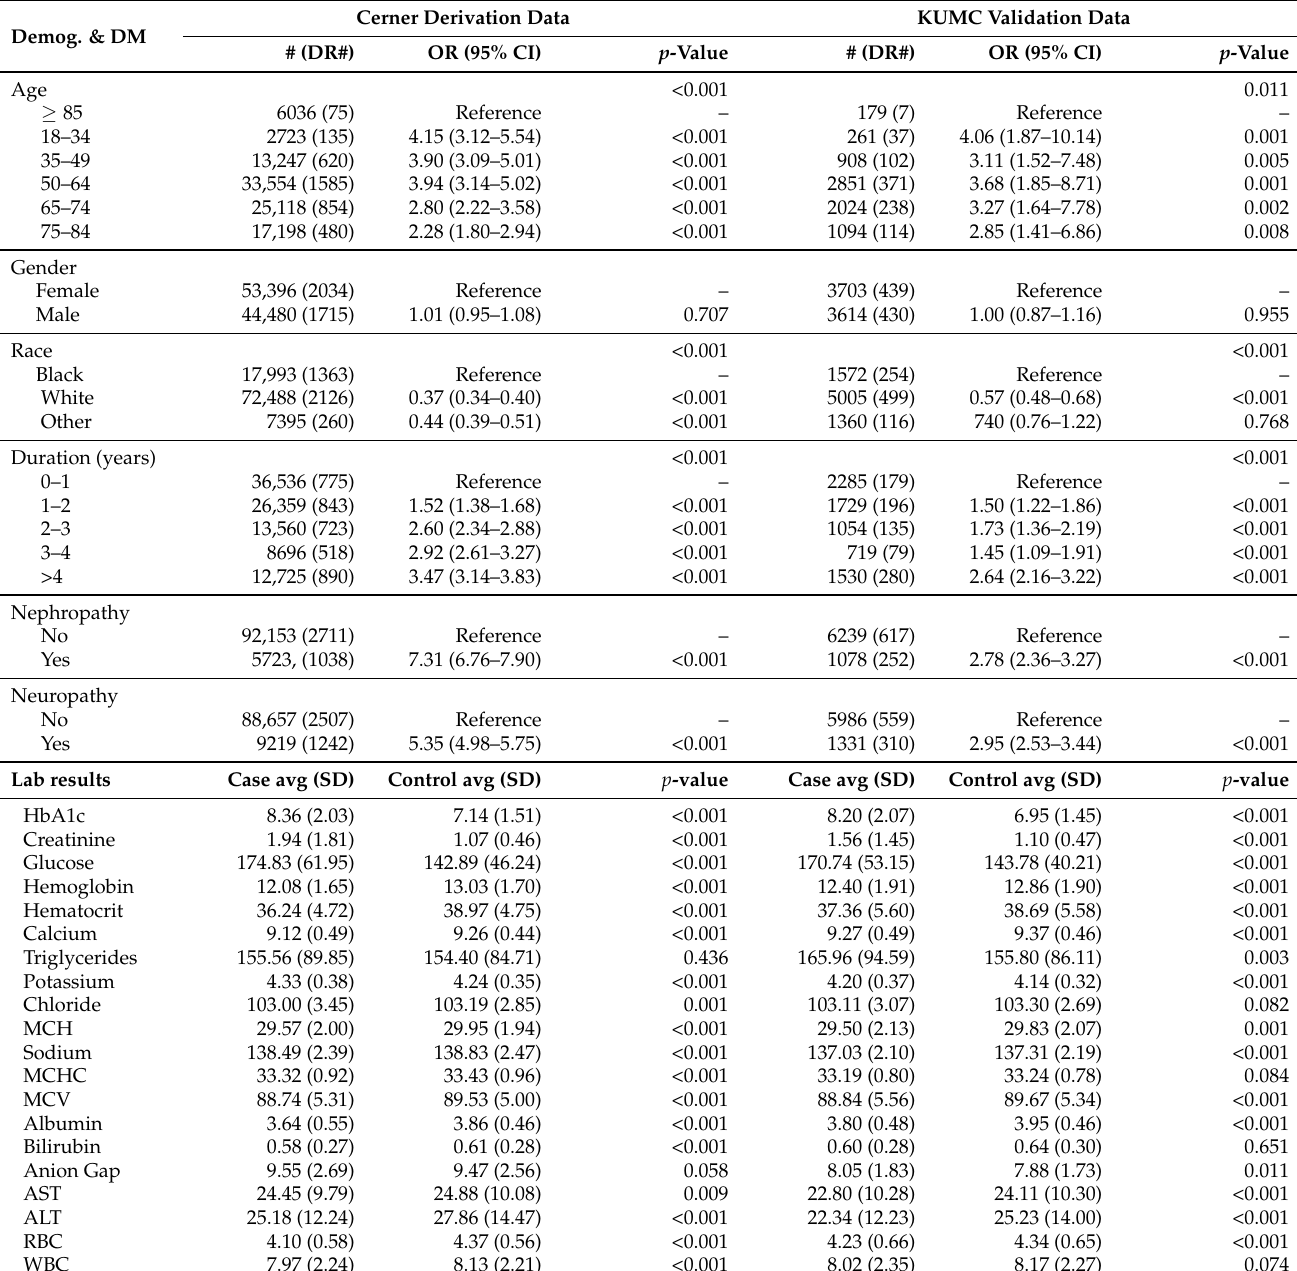
Table 2. Statistics and bivariate analytic results of the derivation and validation